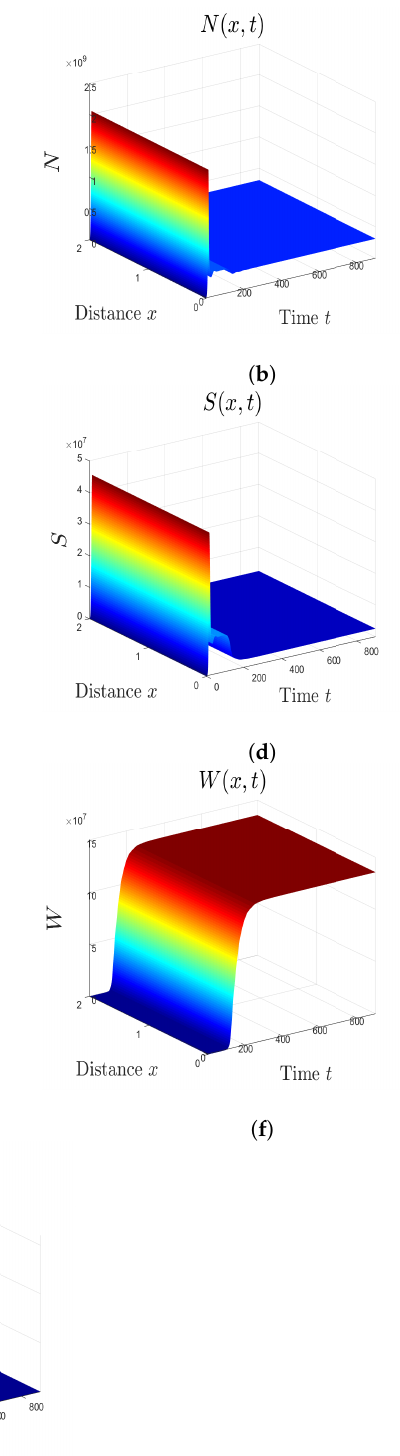
R j ≤ 1. The CTL-activated R l